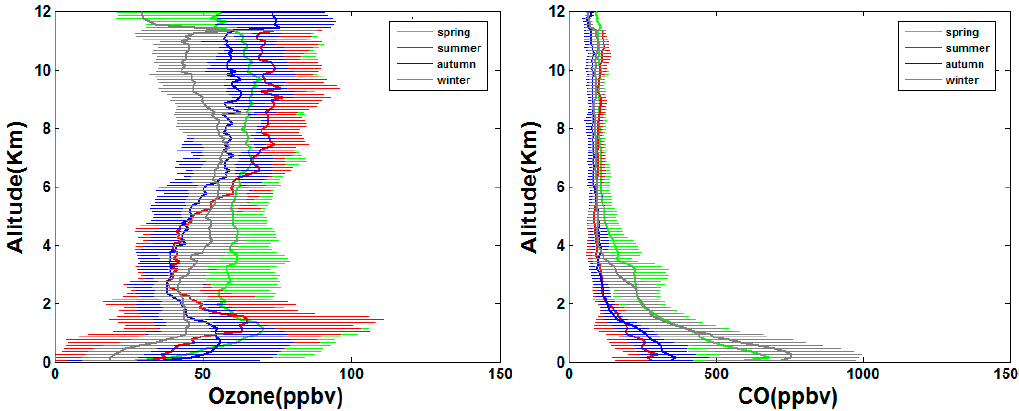
Figure 9. Seasonal-averaged profiles of ozone and CO from MOZAIC (20° N–25° N, 105° E–115° E). Horizontal bars indicate one standard deviation across multiple profiles.